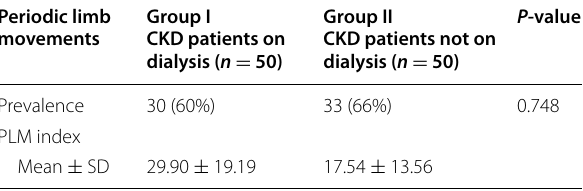
Table 5 Correlation of PLMs with renal function tests and HGB level among both groups of CKD patients